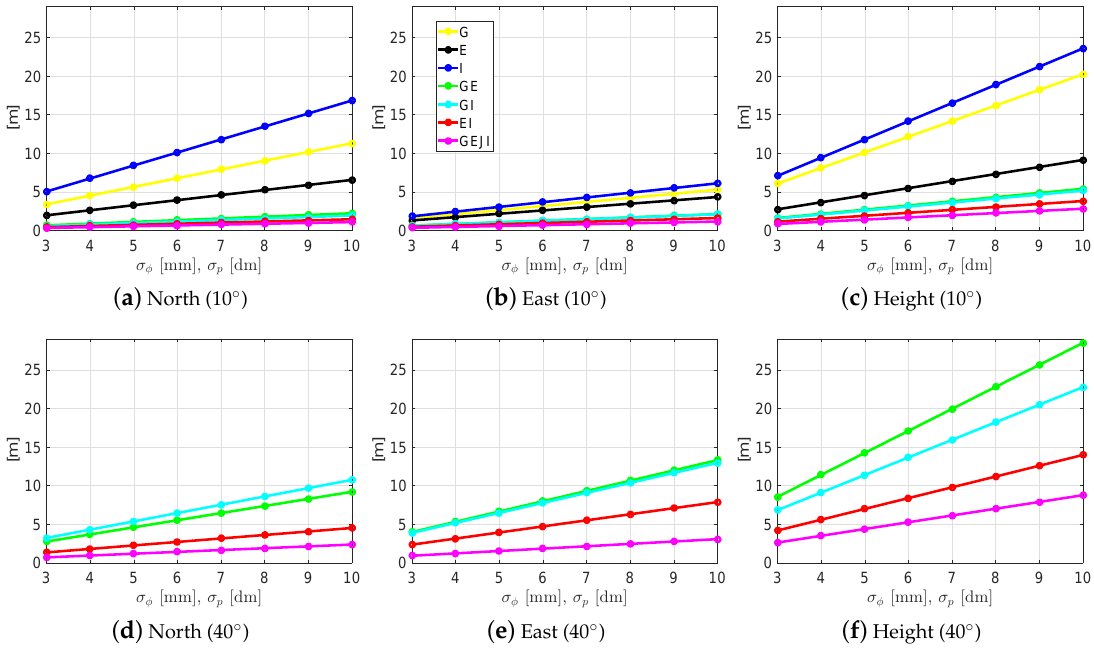
Figure 15. Average ambiguity-float formal standard deviations of the baseline errors for CUAU-CUCU on DOY 224, 2018. The elevation mask was set to be 10 ( a – c ) and 40 degrees ( d – f ). Note that the sub-figures have different